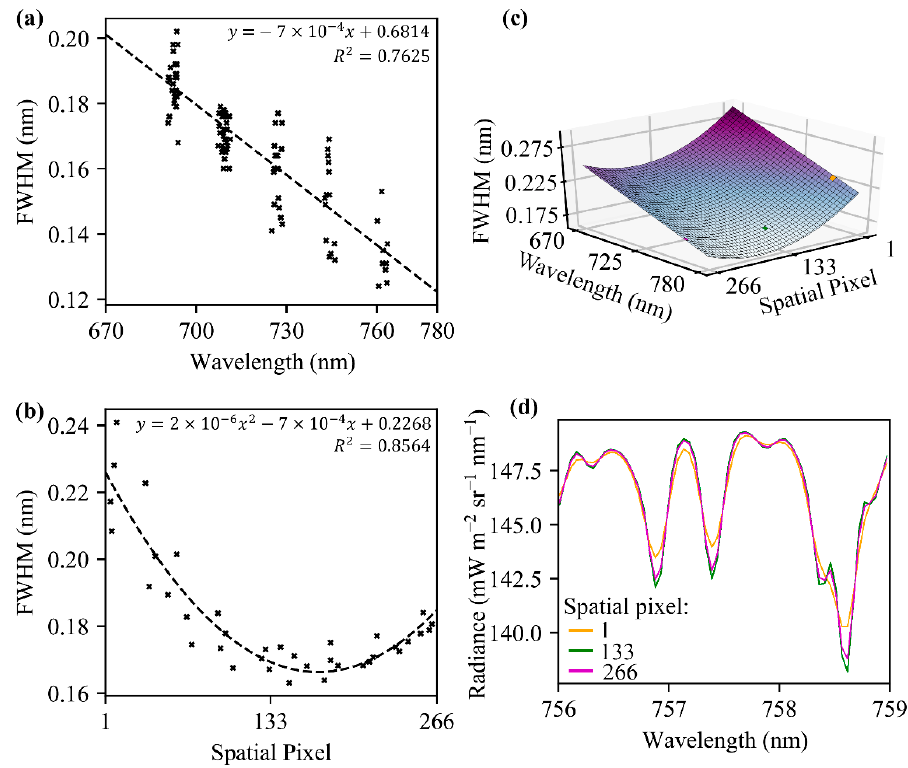
Figure 5. ( a ) The relationship (black dashed line) between FIREFLY FWHM and wavelength for spatial pixel 133, based on observations made with GLAMR (black x); ( b ) the relationship (black dashed line) between FIREFLY FWHM and spatial pixel for spectral band 922 (717.11 nm), based on observations made with the integrating sphere and ASD spectrometer (black x); ( c ) surface showing the combined FIREFLY FWHM function for spatial pixel and wavelength; and ( d ) examples of sections of spectra (colored lines) drawn from different spatial pixels (represented by same colored patches in ( c )).